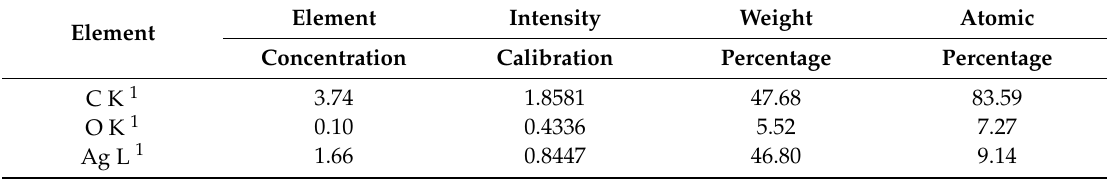
Figure 4. SEM image of PArGO ( a ) and EDS images of silver elemental plane scans ( b ).